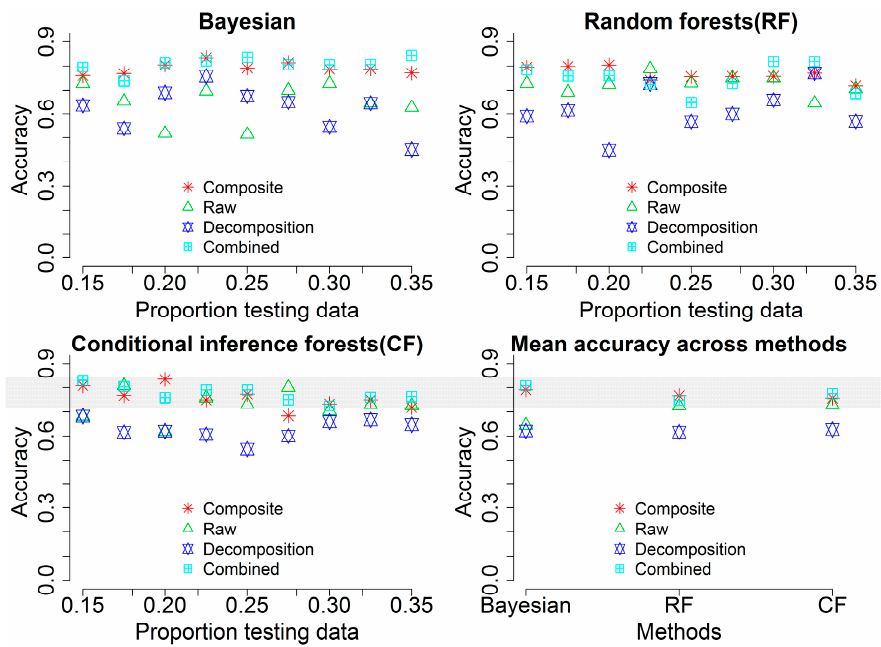
Figure 7. Overall accuracies of classification using variables from different sources such as composite waveforms (Composite), raw waveforms (Raw), waveform-based point cloud (Decomposition) and all combined variables (Combined) with different proportions of testing data across three methods (Bayesian, Random forests (RF) and Conditional inference forests (CF)).